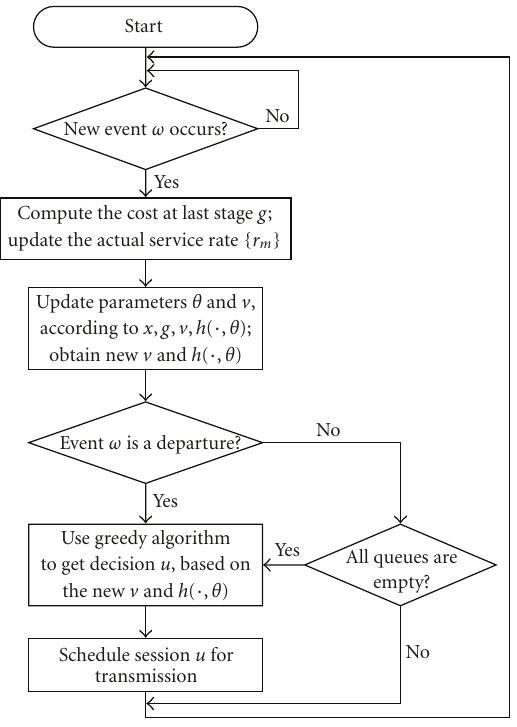
Figure 4: Flow Chart of